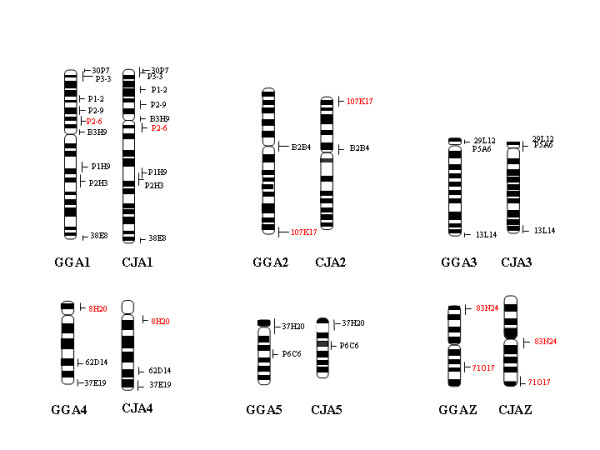
FISH of chicken macrochromosome BAC clones to quail chromosomes. Standard chicken and quail G-banding ideograms are from [52]. Markers mapped to different positions in both species are in red. Results on smaller macrochromosomes and microchromosomes are reported in Table 3.